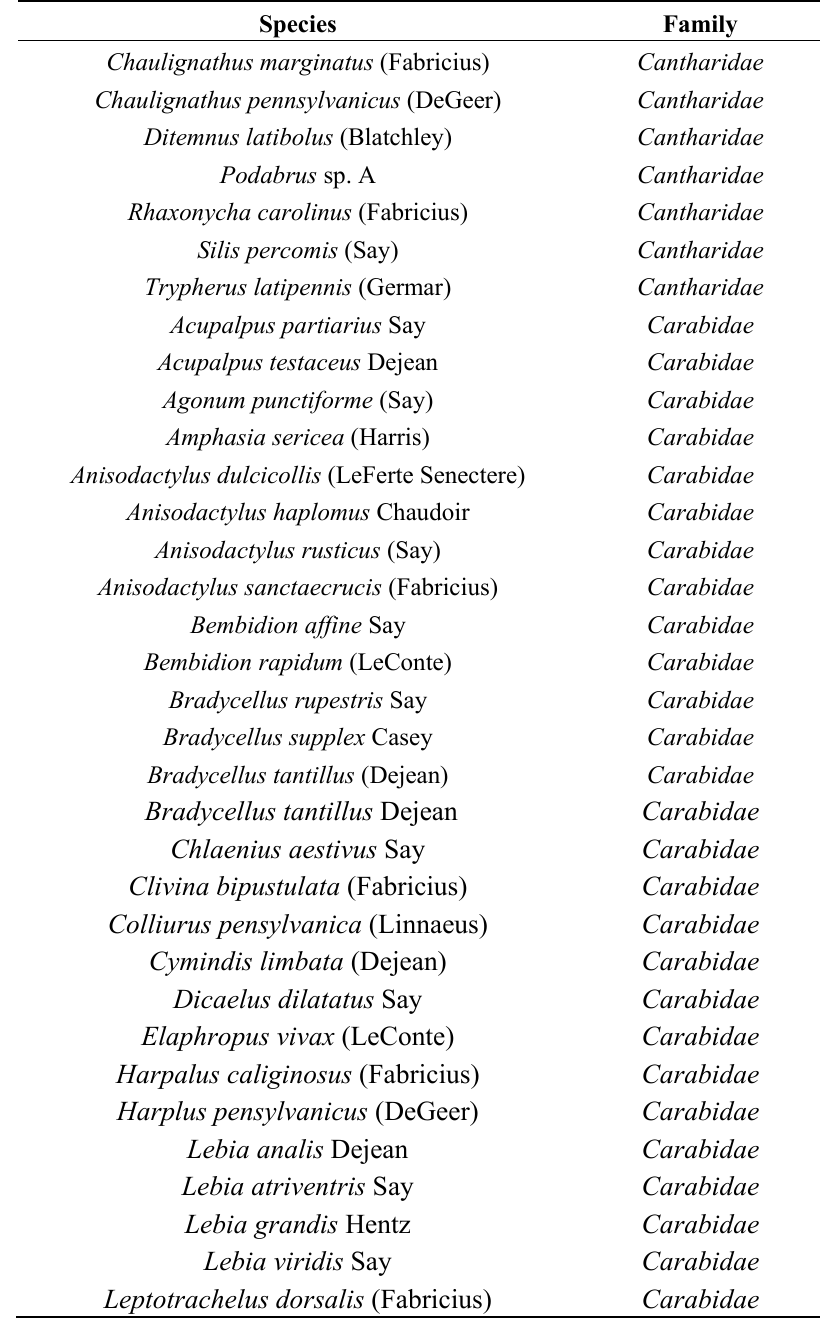
Table A4. A combined species list of all predatory beetles collected in 10 conservation grasslands during June and August of 2009 using both pitfall traps and combination flight-intercept/pan